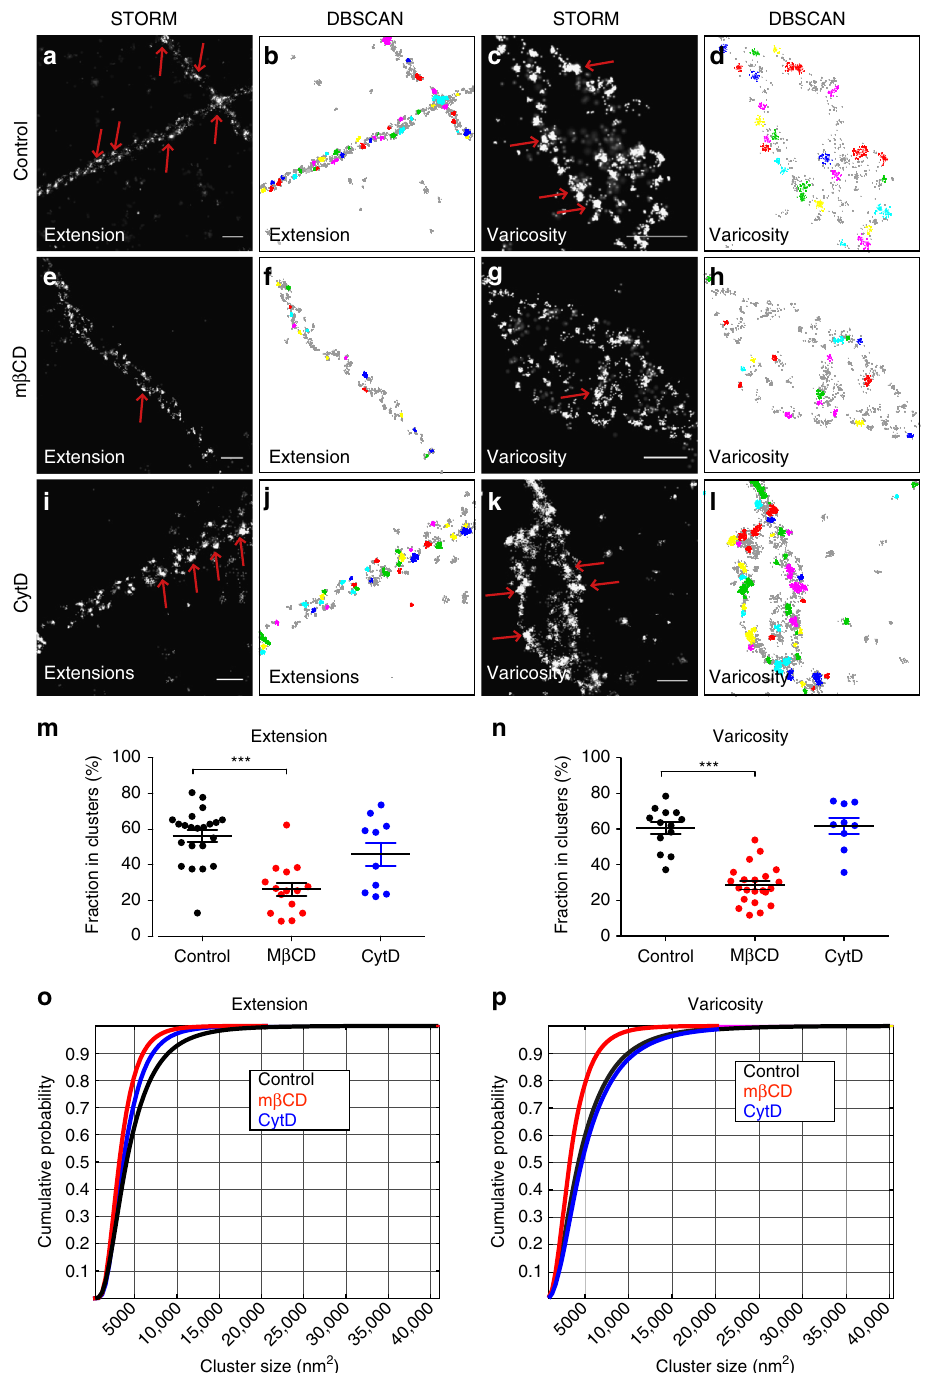
Fig. 4 Cholesterol depletion impairs DAT nanodomain clustering in extensions and varicosities of dopaminergic neurons. a , c , e , g , i , k Representative STORM images showing DAT distribution in extensions and varicosities of dopaminergic neurons under control conditions ( a , c ), after cholesterol removal with 5 mM m β CD ( e , g ), or after actin depolymerization with 5 μ g ml − 1 CytD ( i , k ). DAT was visualized by immunolabeling with primary DAT antibody and Alexa405-Alexa647-conjugated secondary antibody. b , d , f , h , j , l DBSCAN-based cluster maps of the DAT signal in a , c , e , g , i , k . Clustered localizations are shown by color-coding with non-clustered localizations in gray . m , n DBSCAN quanti fi cations DAT nanodomain localization in dopaminergic neurons after cholesterol removal or actin depolymerization, showing m clustering in varicosities and n clustering in extensions. Data are fraction of localizations in clusters in % (means ± s.e.m., *** p < 0.001, one-way ANOVA and Bonferroni ’ s post-test). o , p Probability distribution of the cluster sizes in varicosities ( o ) and extensions ( p ) at control conditions ( black ) or after treatment with m β CD ( red ) or CytD ( blue ). Data are based on from 9 to 39 images from three individual experiments. Red arrows mark DAT clustered in nanodomains. Scale bars 500